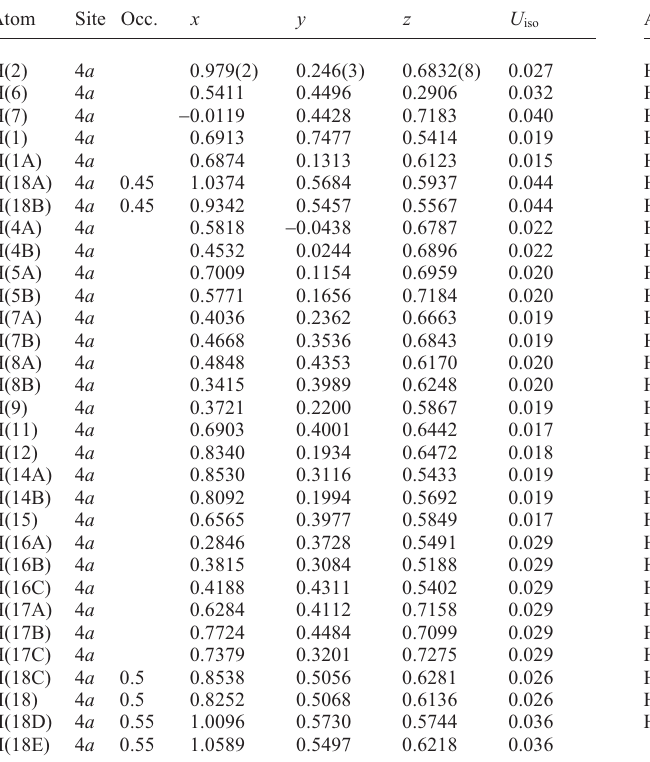
Table 3. Atomic coordinates and displacement parameters (in Å 2 ) .